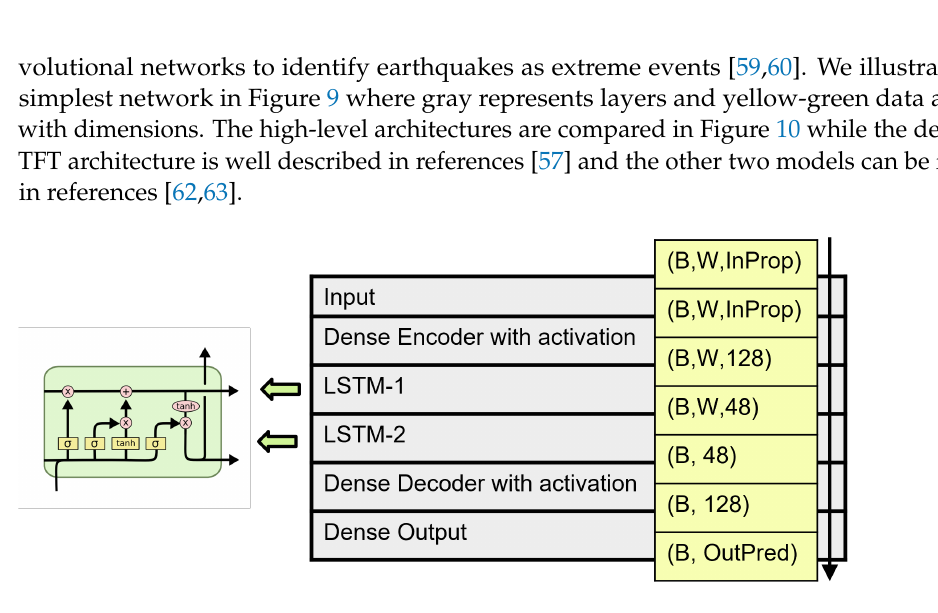
Figure 9. LSTM deep learning network used in this analysis. The 2 LSTM layers are sophisticated compound networks illustrated on the left. B is batch size (400), W is window size (13); InProp is the number of input time series (27) and OutPred the number of predicted time series (24). Table 3. Some features of the 3 models. The # layers are only for the highest level and nearly all of them are composite, so the full count is much